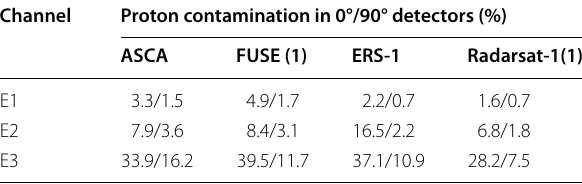
3 days of the anom- ±